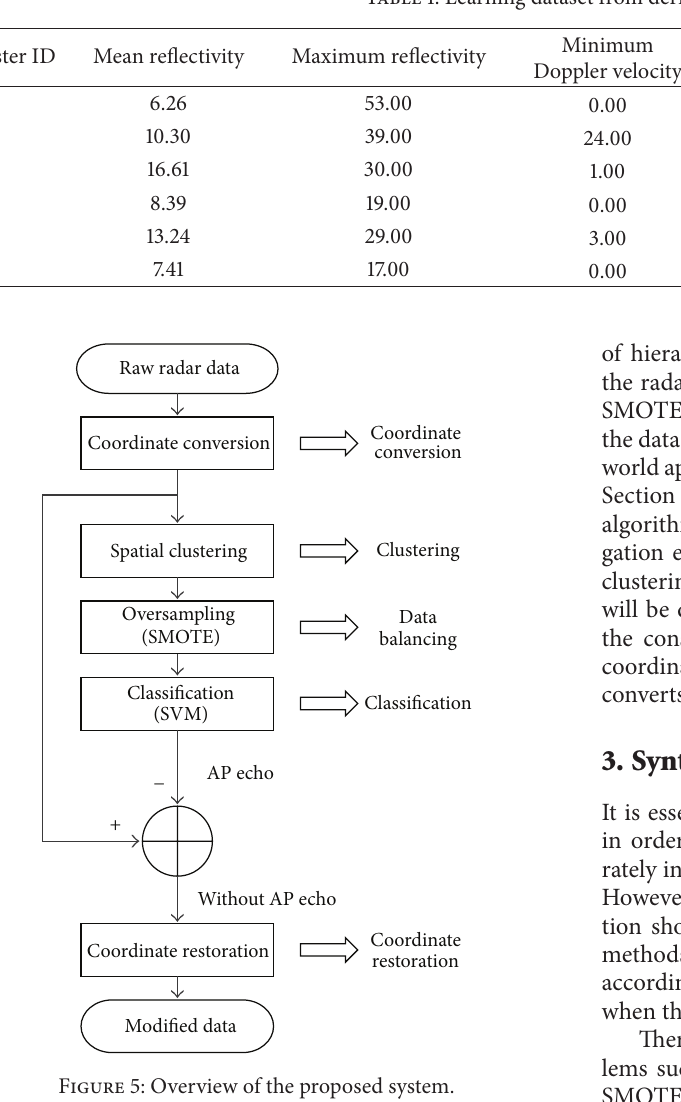
Figure 5: Overview of the proposed